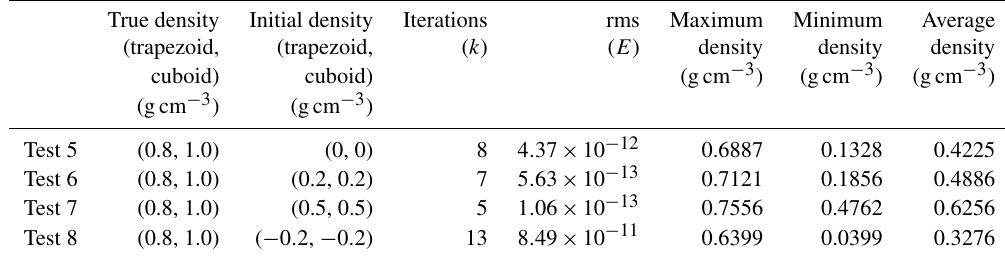
Table 2. Conditions and results for initial density model